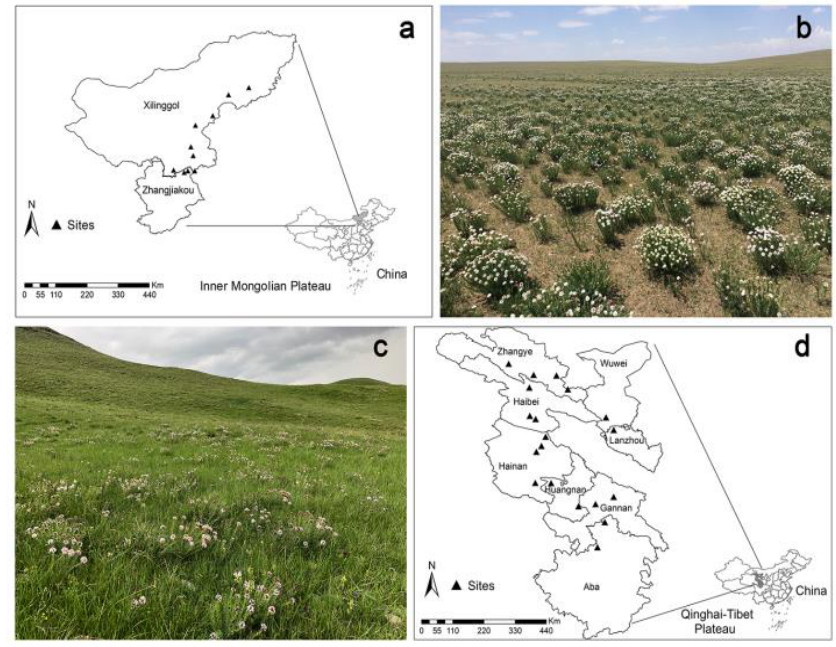
Figure 3. Location of the study and sampling sites. ( a ) Sampling sites on the Inner Mongolia Plateau; ( b ) S. chamaejasme coverage in Taipusi Banner in Inner Mongolia Plateau; ( c ) Sampling sites on the Qinghai-Tibetan Plateau; and ( d ) S. chamaejasme coverage in Qilian County in Qinghai-Tibetan Plateau.